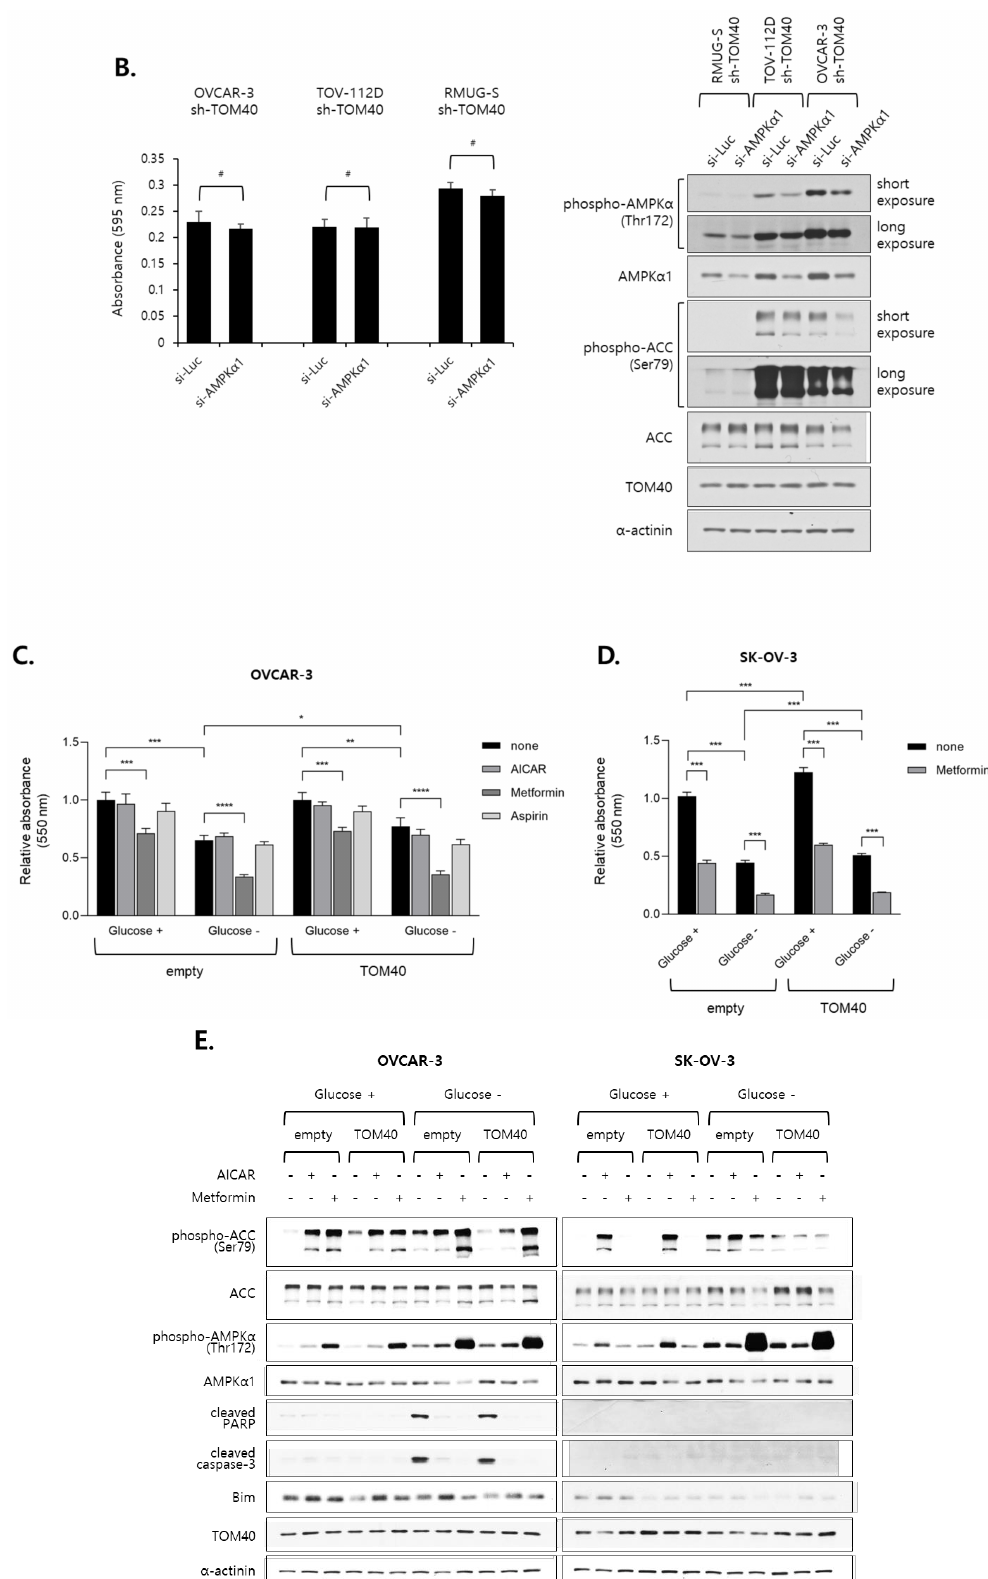
Figure 6. Metformin reduces EOC cell growth in an AMP-activated protein kinase (AMPK)-independent manner. ( A ) Epithelial ovarian cancer (EOC) cell lines that stably express sh-control or sh-TOM40 were harvested at 70% confluency. The expression levels of indicated proteins were measured by western blot analysis. ( B ) sh-TOM40 stably expressed EOC cells were introduced to si- Luciferase or si-AMPK α 1 and then incubated in a CO 2 incubator (5% CO 2 and 37 ℃ ) for 72 h. Cell viability was assessed by crystal violet assay (Left panel). Data in the bar graph are expressed as the mean of absorbance ± Standard Deviation (S.D.)., n = 16. # p > 0.05. The expression levels of indicated proteins including anti-AMPK α 1 were measured by western blot analysis (Right panel). ( C ) Cell